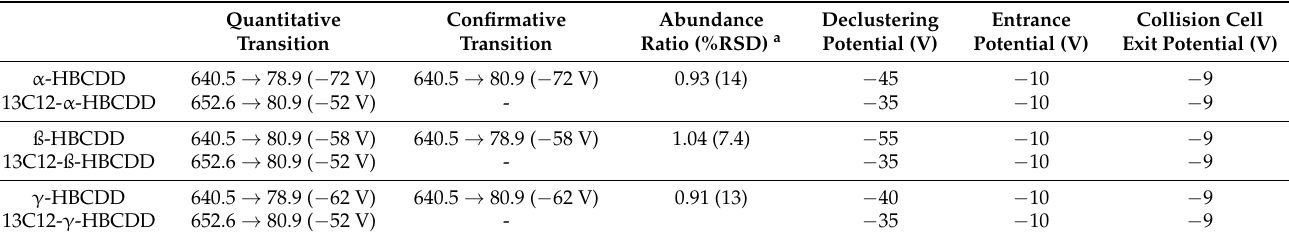
Table 2. Optimised detection parameters for